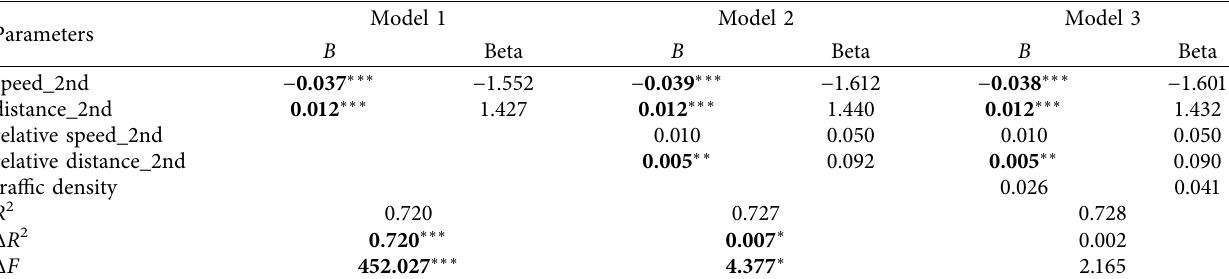
Table 8: Results of the average deceleration based on the following